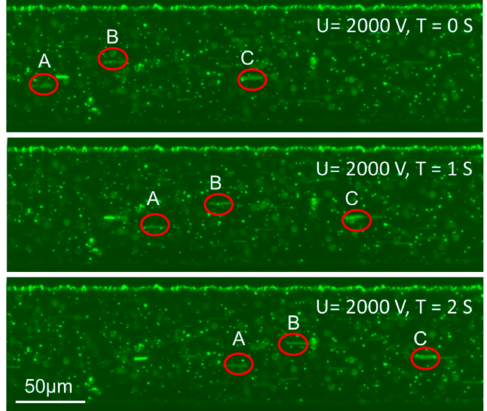
Figure 4. Sequential photographs of 0.5 µ m polystyrene particles in 200 µ m-wide microchannels. The average velocities of the three particles measured in µ m/s were: A = 109, B = 105, C =